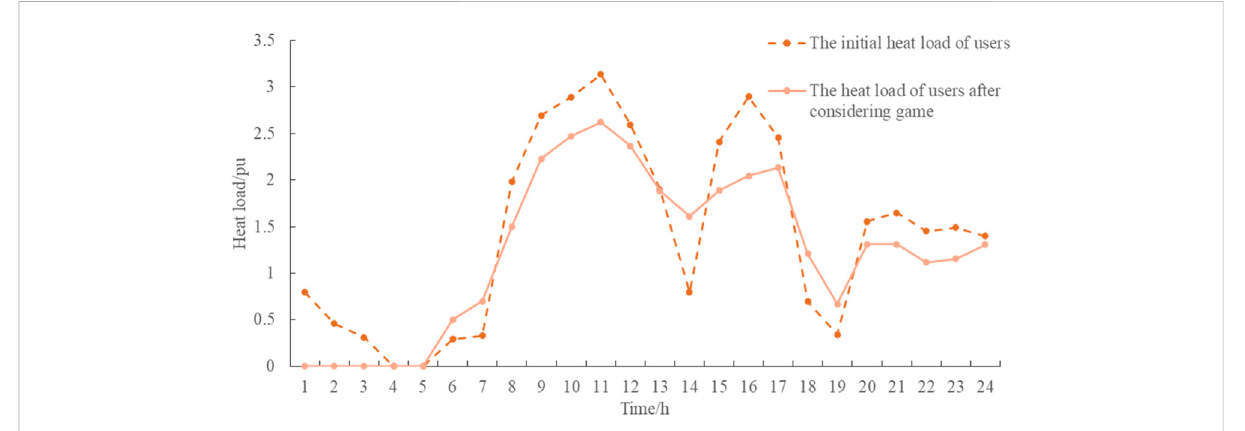
FIGURE 9 Comparison between users ’ initial heat load and heat load after considering the